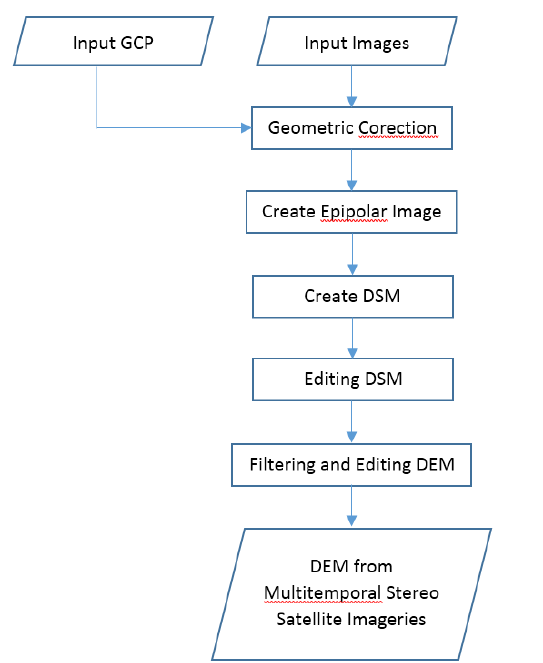
Figure 6. Flowchart making a DEM from Multitemporal Stereo Satellite Imageries